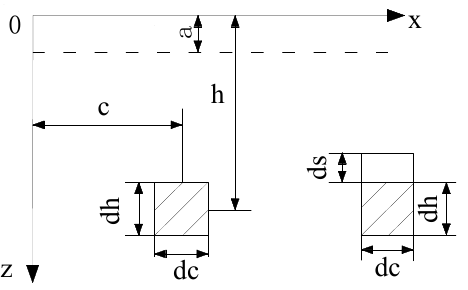
Figure 10. Consolidation-drainage-deformation model of karst aquifer.